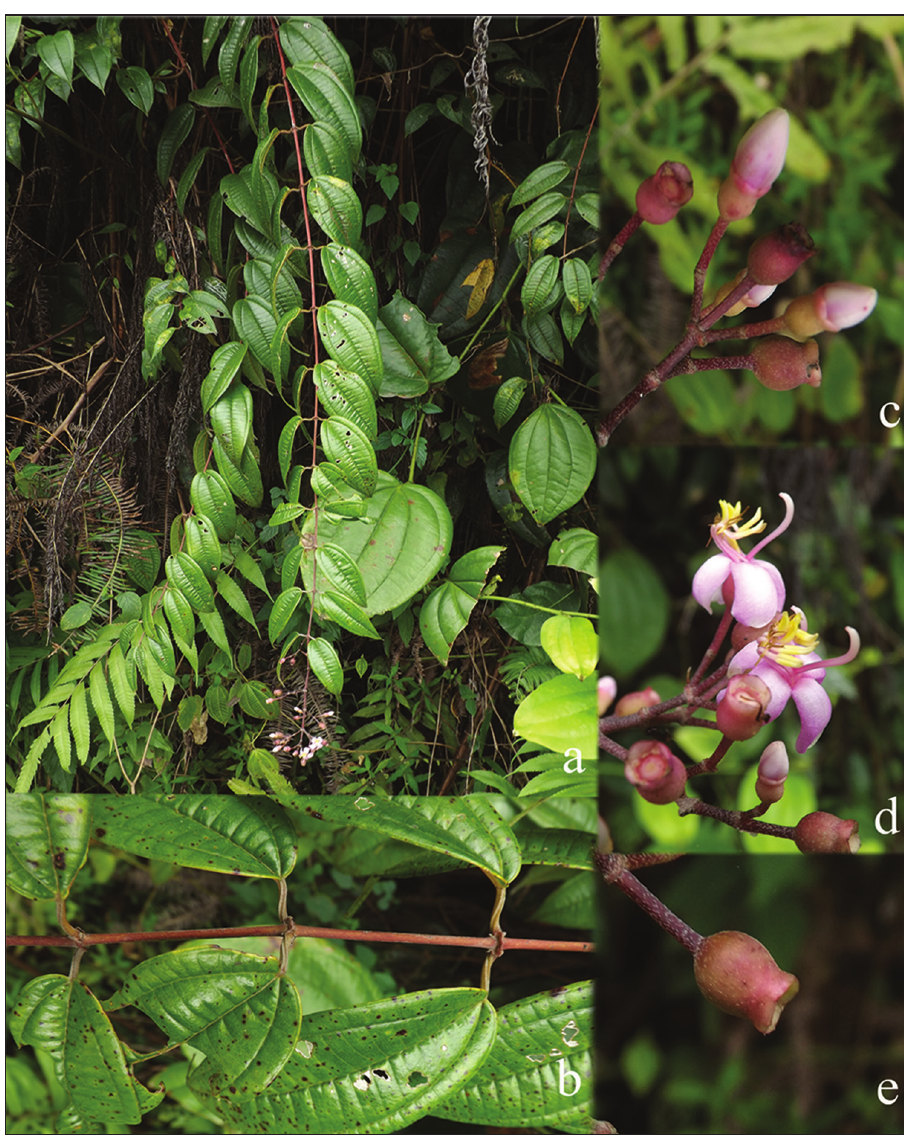
Figure 27. Dissochaeta vacillans . a habit b branchlet c hypanthium d flowers e immature fruit. Photo- graphs by A. Kartonegoro; voucher: Kartonegoro 1105